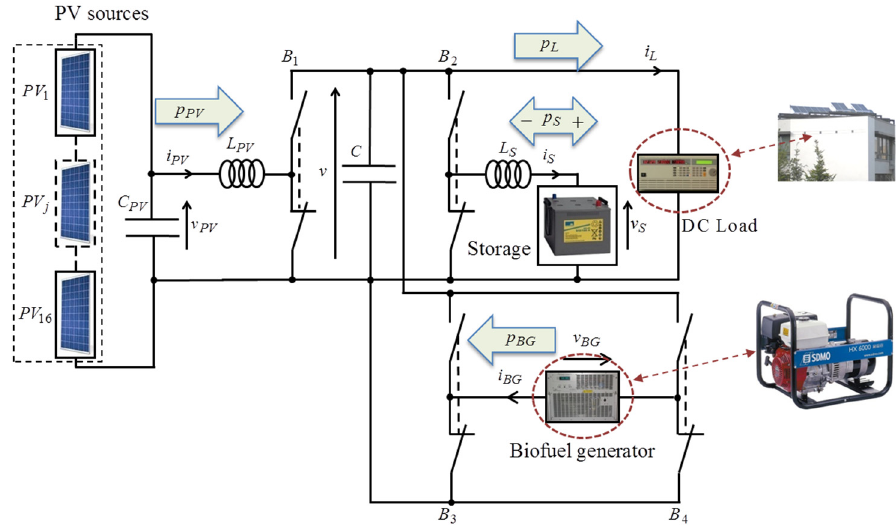
Figure 4. Electrical scheme of experimental